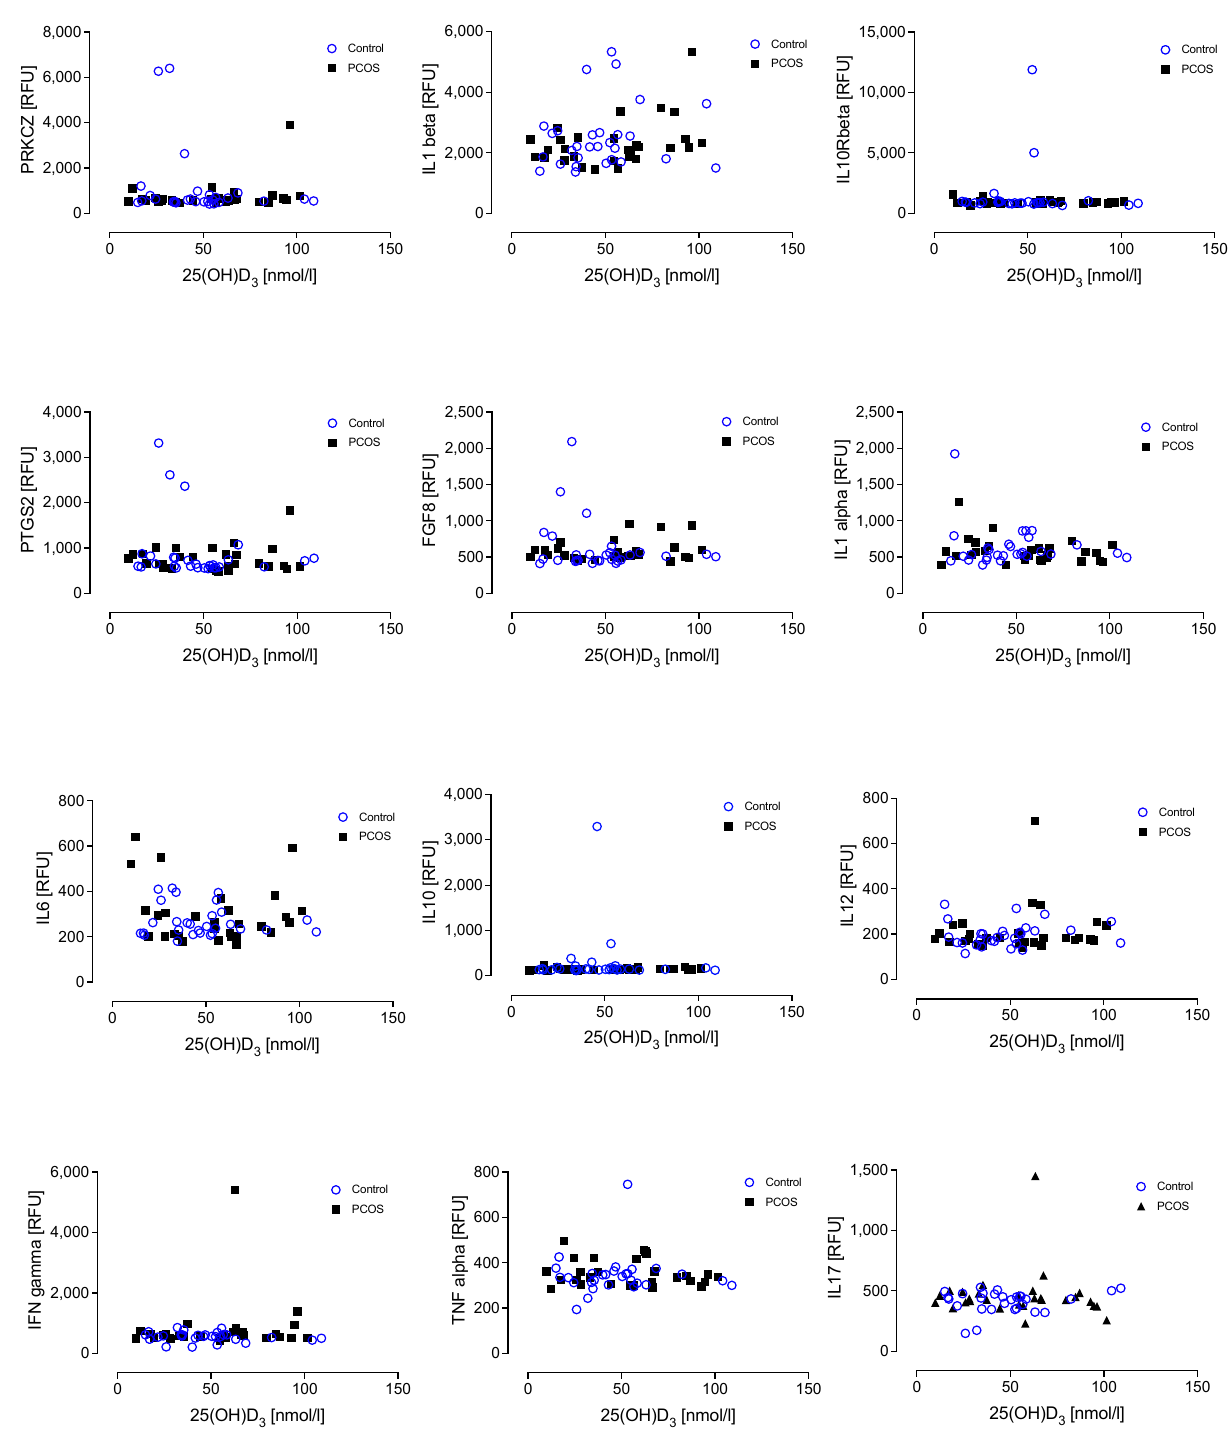
Figure 3. No relationship was found between Vitamin D 3 and the inflammatory markers Protein kinase C zeta type (PRKCZ), Interleukin-1 beta (IL1beta), Interleukin 10 receptor beta subunit (IL10Rbeta), Prostaglandin G/H synthase 2 (PTGS2), Fibroblast growth factor 8 (FGF8), Interleukin-1 alpha (IL1alpha), IL6, IL10, IL12, Interferon gamma (IFN-g), Tumour necrosis factor alpha (TNF-a) and IL17.